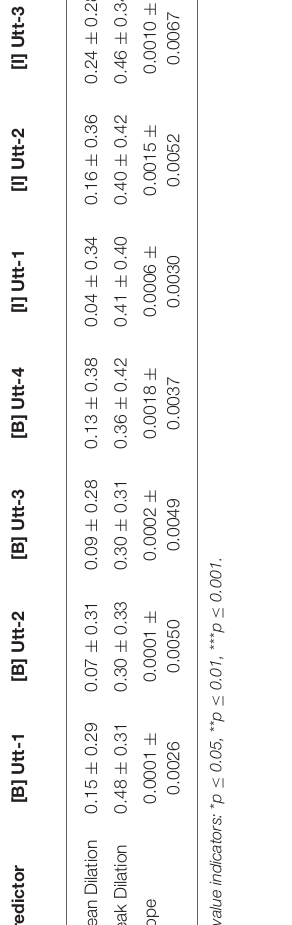
and disfluencies (Heeman and Allen, 1999). Eventually,